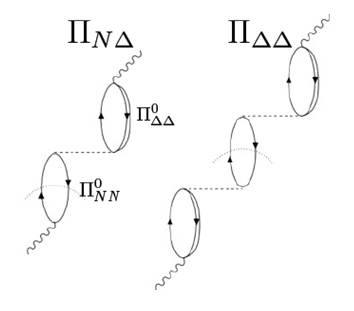
Figure 8. Diagrammatic structure of the RPA polarization prop- agators. For brevity we use the notation Π NN ≡ Π NN , NN and ≡ Π Π ΔΔ N Δ , N Δ etc.